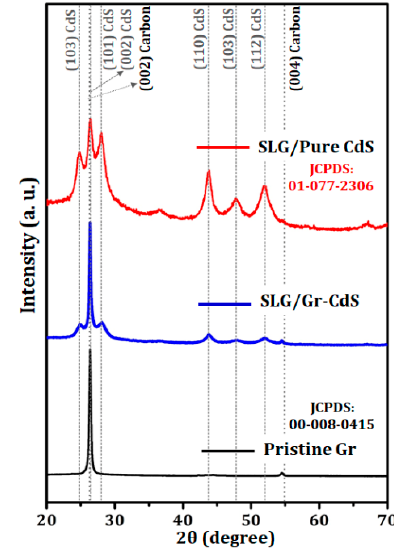
Figure 4. XRD results of pristine graphene, Gr–CdS nanocomposite, and pure CdS NPs.